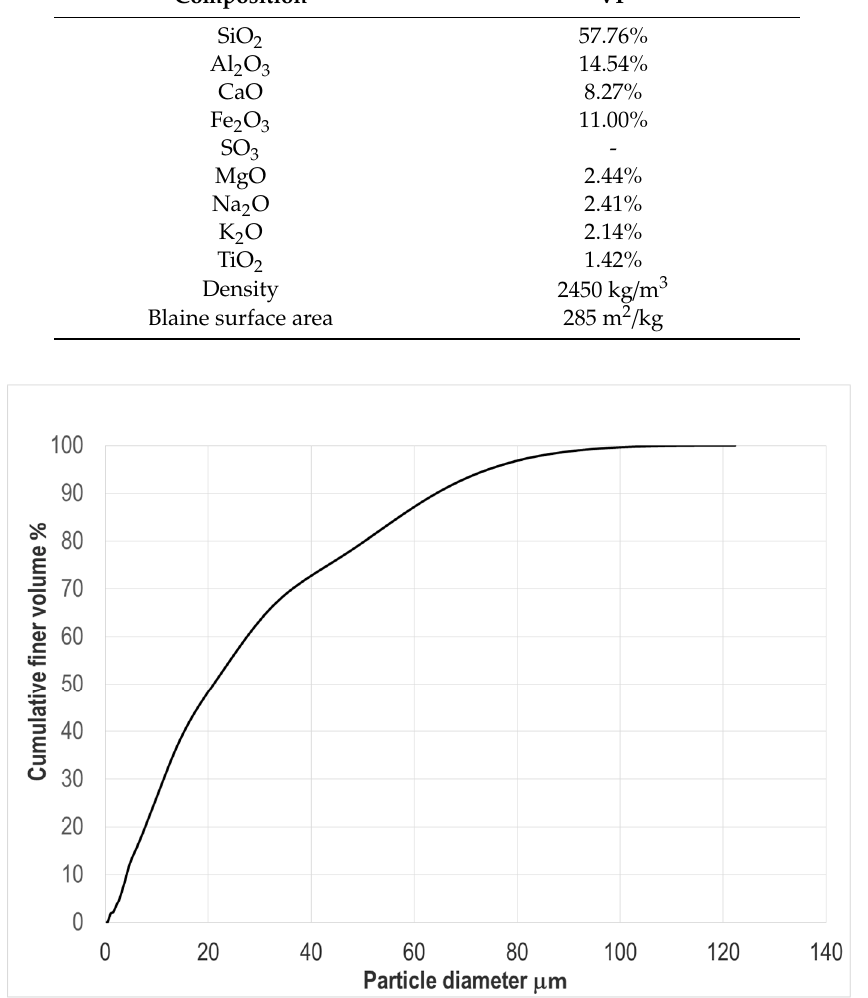
Figure 1. Grain size distribution of volcanic powder (VP).